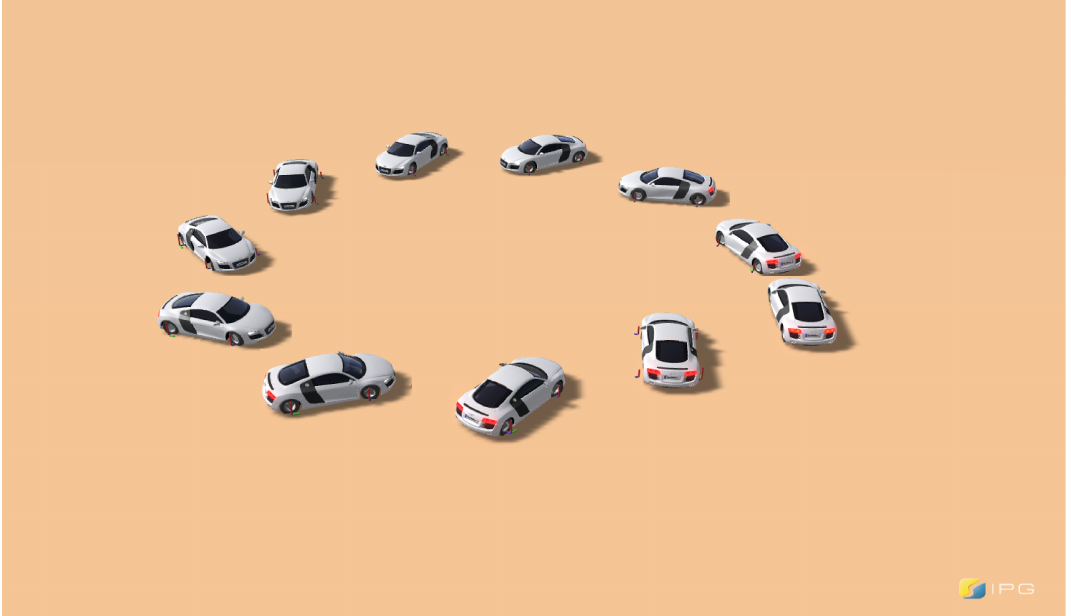
Figure 10. A promising novel ADAS system for vehicle manoeuvrability enhancement on loose surfaces: Autonomous Drift Control (ADC)